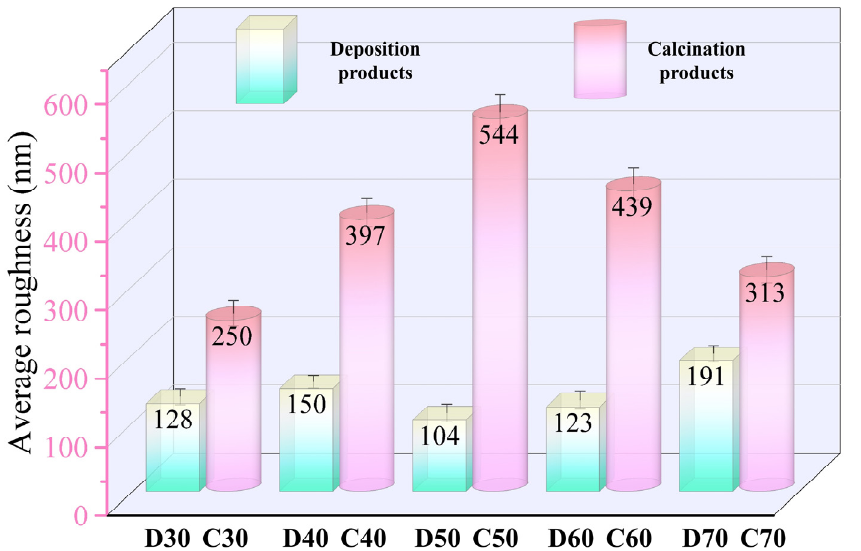
Figure 11. Average roughness of the deposition products (D30 − D70) and calcination products (C30 −